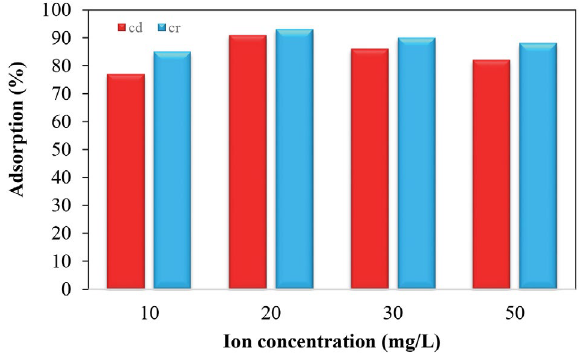
Fig. 6: The effect of initial concentration of cadmium and chromi- um in conditions in terms of (cadmium pH: 6, chromium pH: 7, adsorbent dosage 20 g/L, time 50 min and temperature 25